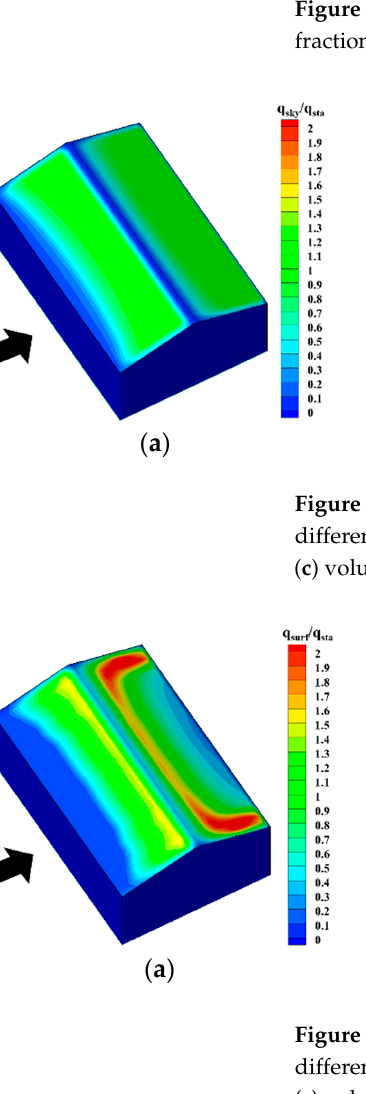
Figure 23. Spatial distribution of the normalized total deposition flux q total / q sta with different snow- fall intensities: ( a ) volume fraction: 7.8 × 10 − 6 ; ( b ) volume fraction: 1.56 × 10 − 5 ; ( c ) volume fraction: 2.34 × 10 − 5 . 6. Conclusions The study proposed a Eulerian–Eulerian approach for snow distribution, by con- sidering the motions of different snow phases. Based on the validated approach, a series of CFD simulations are conducted to study the influence of snowfall conditions on snow loads on gable roofs. Finally, the following conclusions are derived: 1.